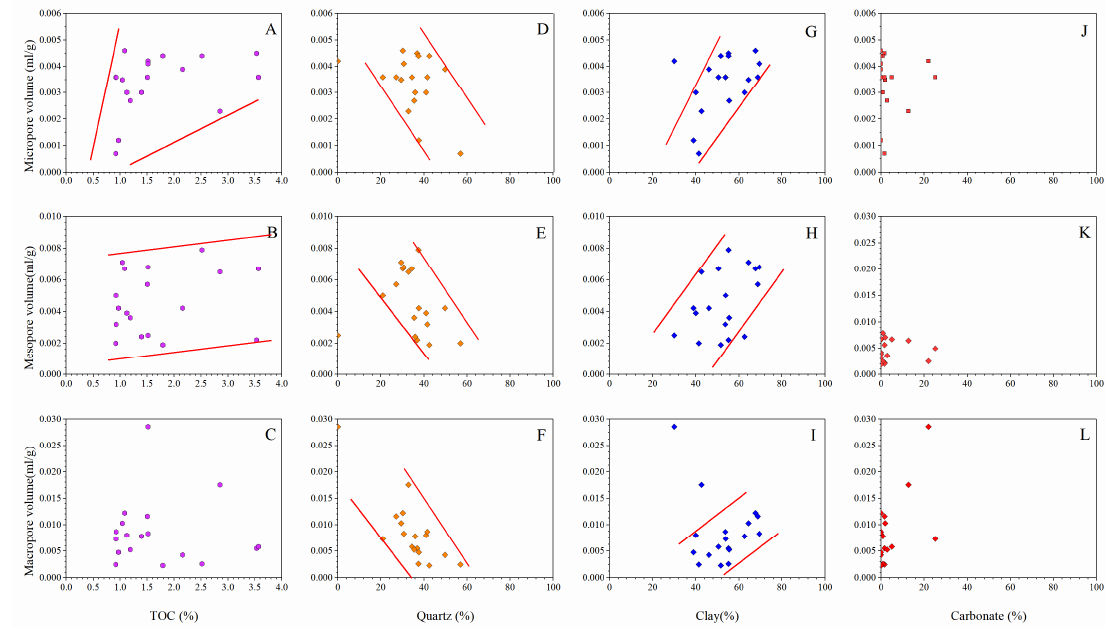
Figure 11. Relationships between pore structure parameters and TOC, mineral compositions: (A) Micropore volume versus TOC content; (B) Mesopore volume versus TOC content; (C) Macropore volume versus TOC content; (D) Micropore volume versus quartz content; (E) Mesopore volume versus quartz content; (F) Macropore volume versus quartz content; (G) Micropore volume versus clay mineral content; (H) Mesopore volume versus clay mineral content; (I) Macropore volume versus clay mineral content; (J) Micropore volume versus carbonate mineral content; (K) Mesopore volume versus carbonate mineral content; (L) Macropore volume versus carbonate mineral content.